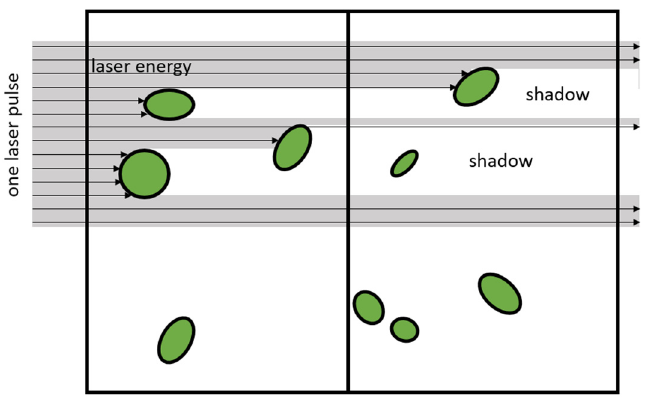
Figure 2. Sketch of a laser beam in grey hitting two sampling volumes (boxes) from the left side. The vegetation parts are drawn in green color. They are of smaller diameter than the beam.